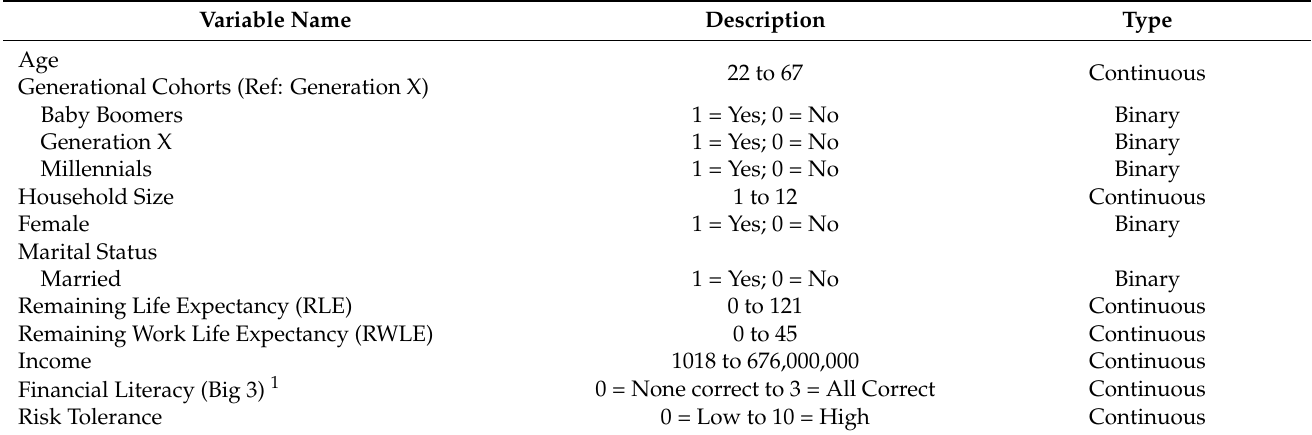
Table A1. Description of the Variables used in the